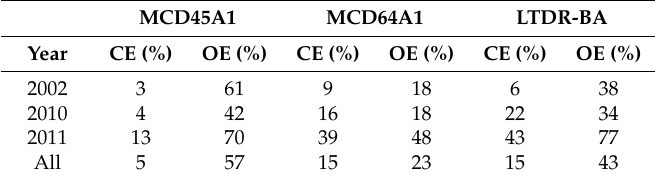
Table 5. Commission (CE) and omission (OE) errors (%) for MCD45A1, MCD64A1, and LTDR BA products versus the reference Landsat-TM data for the Northeastern Siberian boreal region in 2002, 2010, and 2011.